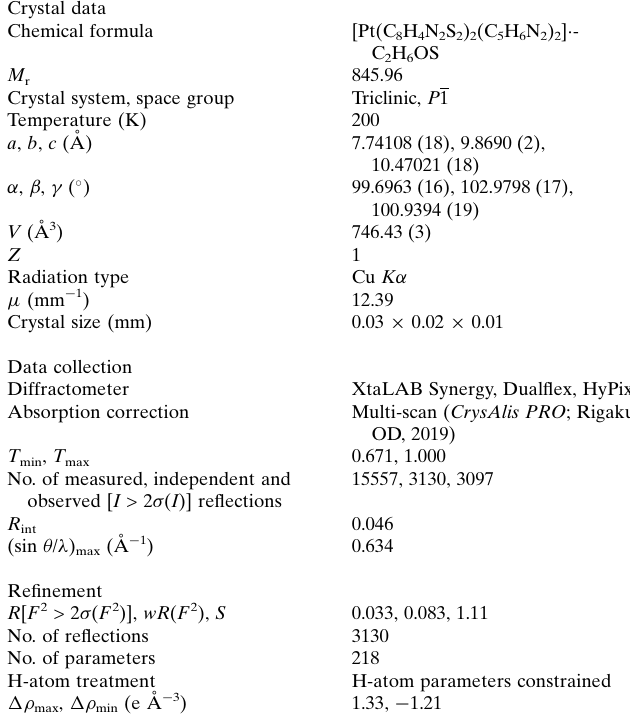
Table 2 Experimental details. Crystal data Chemical formula